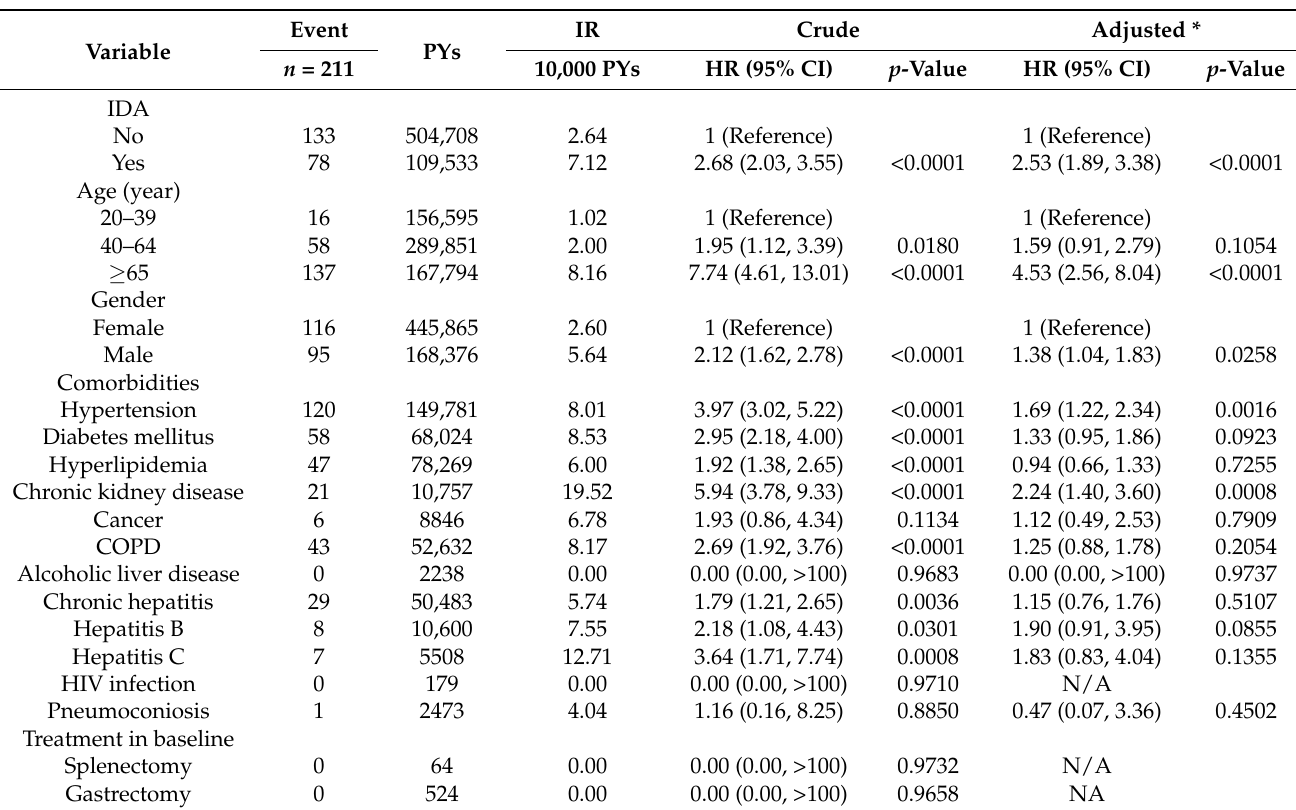
Table 2. The incidence rate and hazard ratio of septic arthritis (SA).